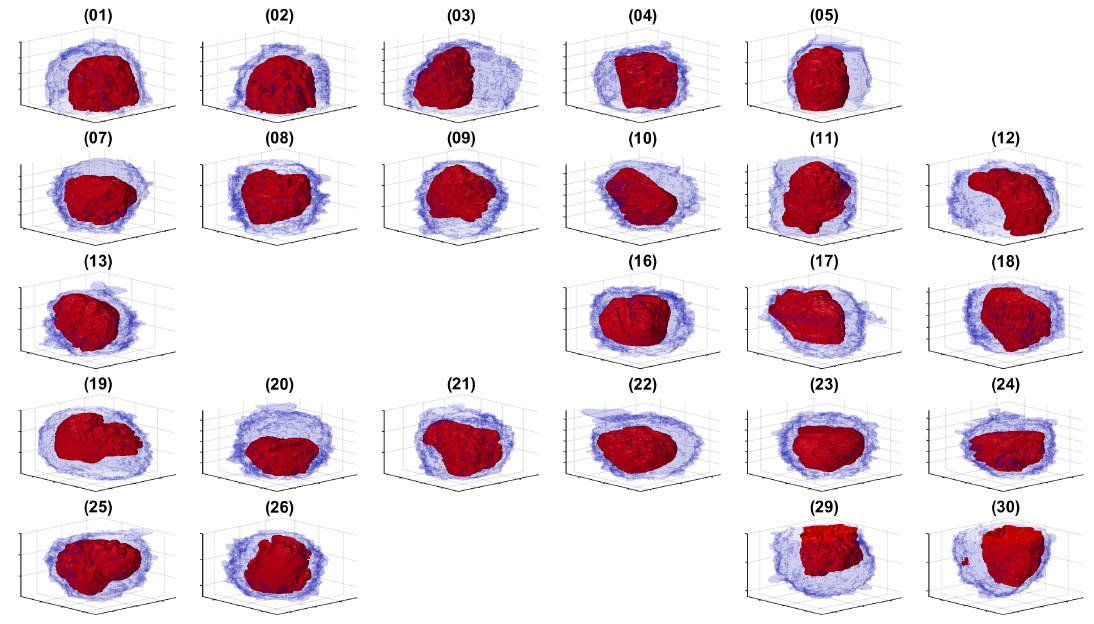
Figure 7. Rendering of the cell and nuclear envelope (NE) of 25 cells. For each case, the NE is rendered in red without transparency, and the cell membrane is rendered in blue with transparency. The cells in ROIs 6,14,15,27 and 28 were located on the edges of the volume, and the centroids were too close to the edges and thus discarded. For comparison purposes, the cells were placed in the same locations as in Figure 6, and the ROIs that were discarded are